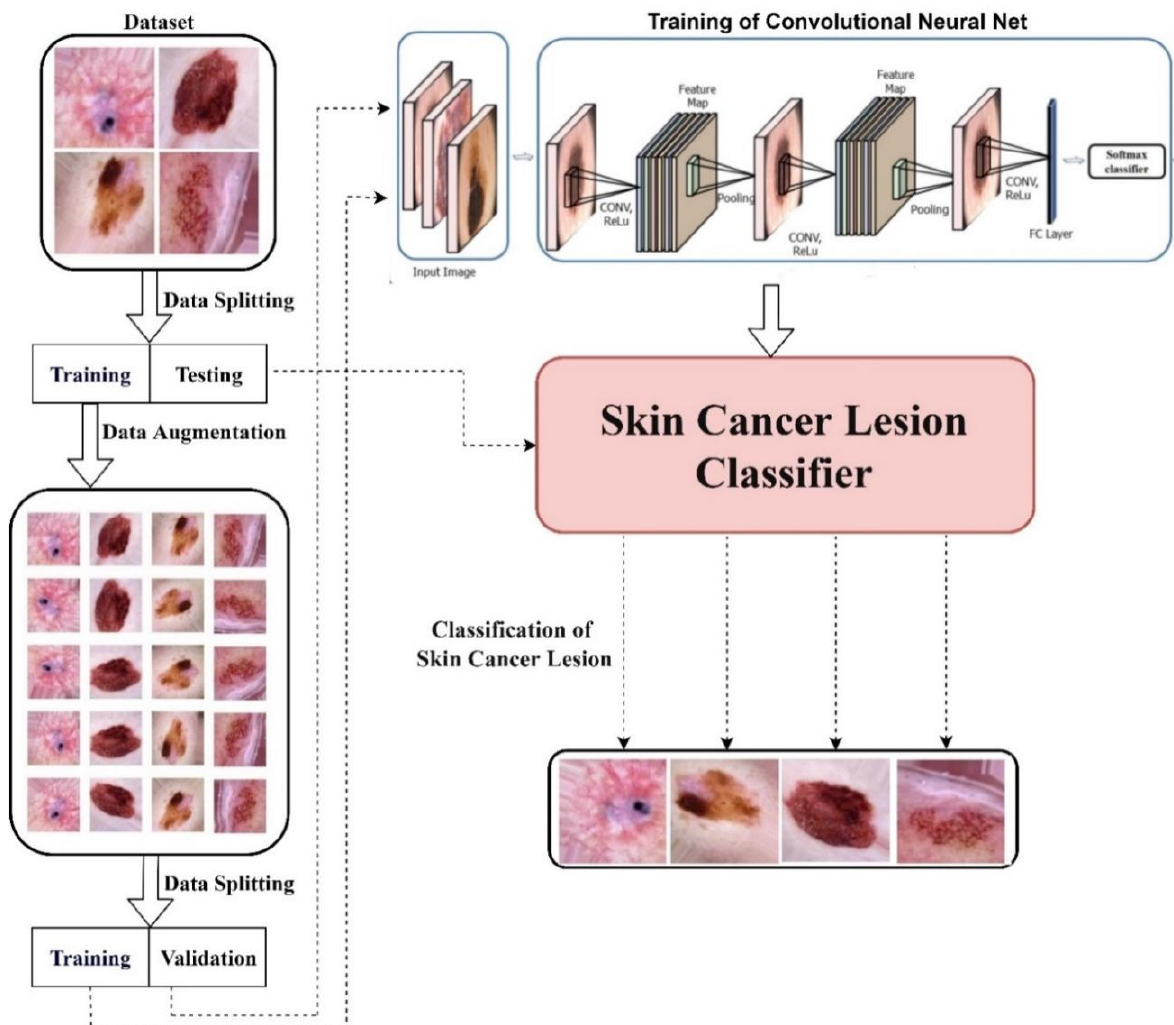
Figure 1. Proposed framework.